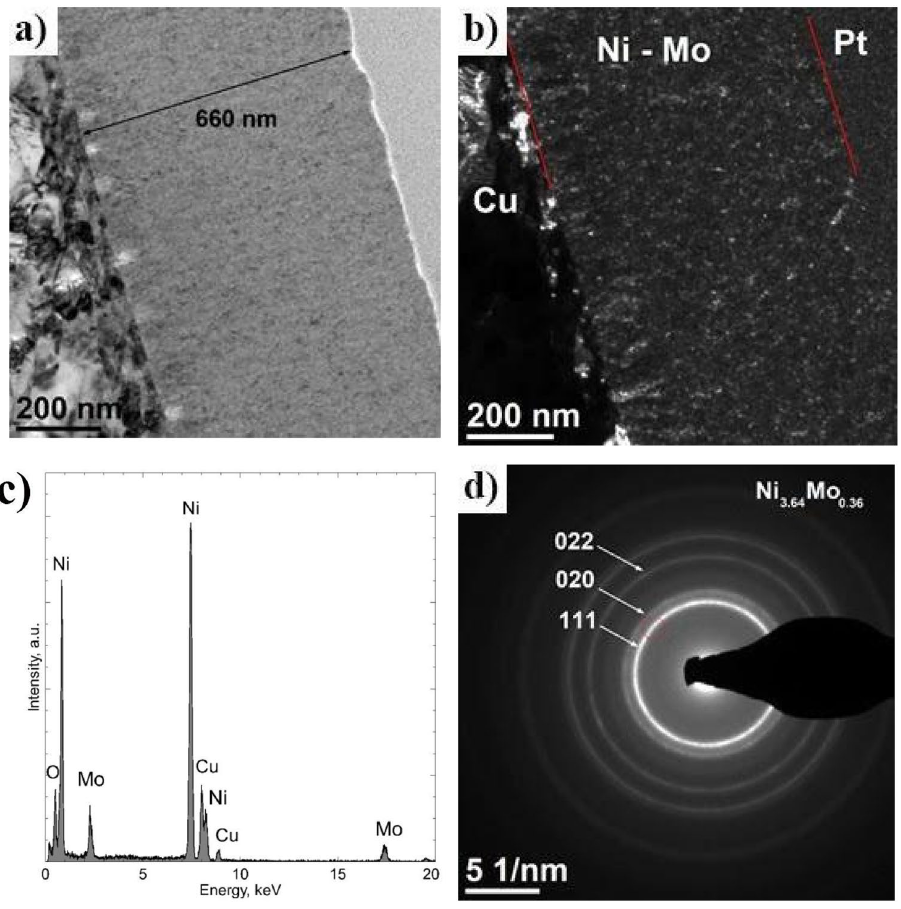
Figure 7. Cross section of the Ni–Mo coating deposited at − 0.6 V vs. Ag for 1 h at 50 °C: TEM BF image ( a ), DF TEM image ( b ), EDS analysis result in the area of coating ( c ), SAED, the red color (circle) marks the position of the objective aperture used to obtain the DF ( d